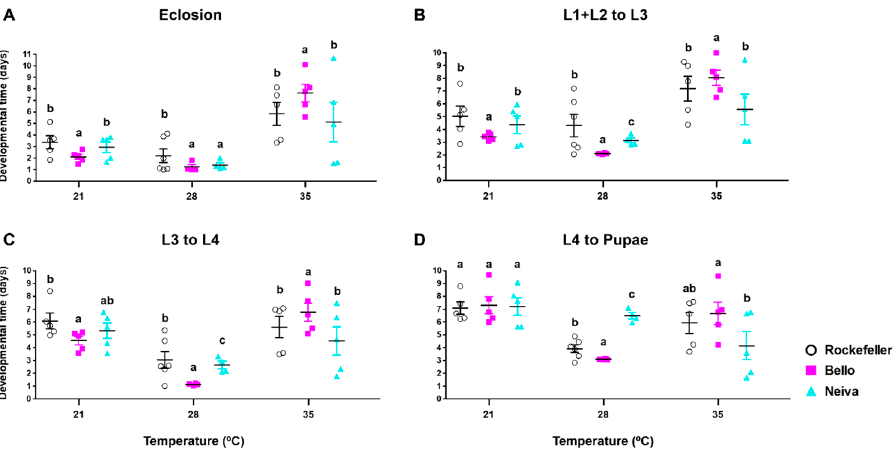
Figure 7. Developmental time (days) of each immature instar of two Colombian Ae. aegypti popula- tions reared at 21 ± 1 °C, 28 ± 1 °C and 35 ± 1 °C temperatures, 80 ± 5% relative humidity, and 12 h light: 12 h dark photoperiod. ( A ) Eclosion, ( B ) L1 + L2 to L3, ( C ) L3 to L4, and ( D ) L4 to Pupae. The mean and standard error of the mean were plotted. Each point represents a replicate that started from a cohort of 100 eggs in each. The total number of replicates were: Bello and Neiva 28 ± 1 °C (4); control Rockefeller 28 ± 1 °C (6); Bello, Neiva and control Rockefeller 21 ± 1 °C and 35 ± 1 °C (5). L: larvae. The time to pupation is the mean development time from L4 to pupae. One-way analysis of variance (ANOVA) was conducted, followed by a Bonferroni post-hoc test to account for multiple comparisons between Ae. aegypti populations at the same temperature by age. Populations sharing the same letters are not significantly different ( p > 0.05).